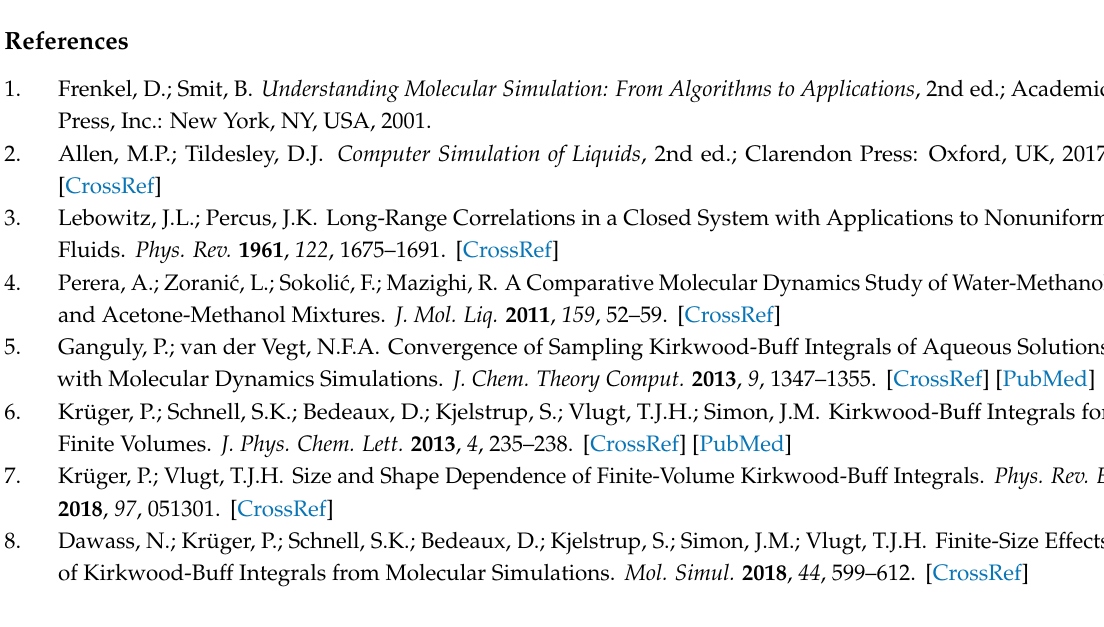
∞ • s vs. α , Figure S3: χ s and χ s vs. vs. α H − bonds